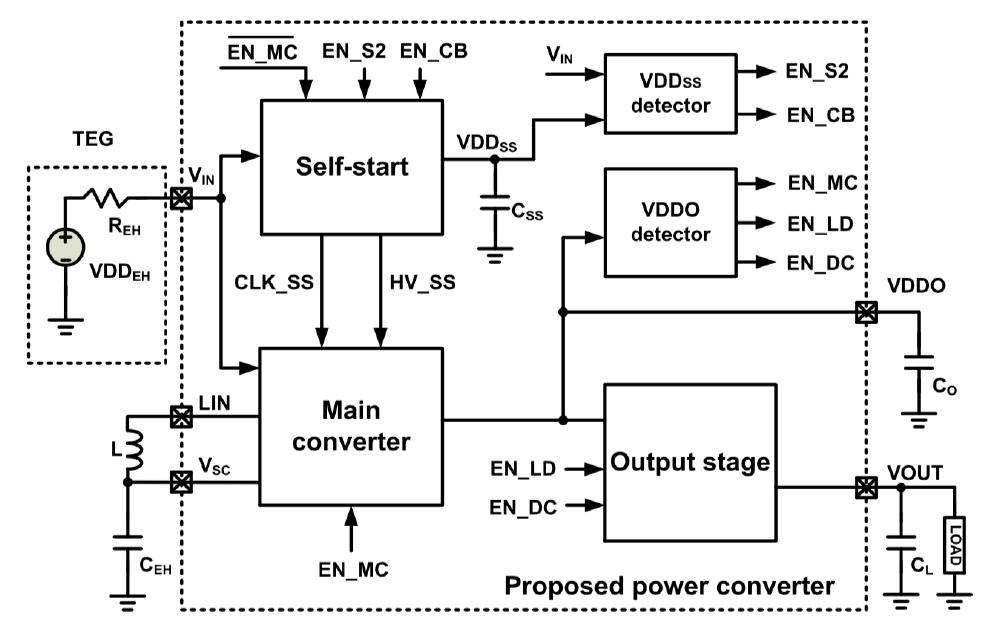
Figure 13. The hybrid converter presented in [35].